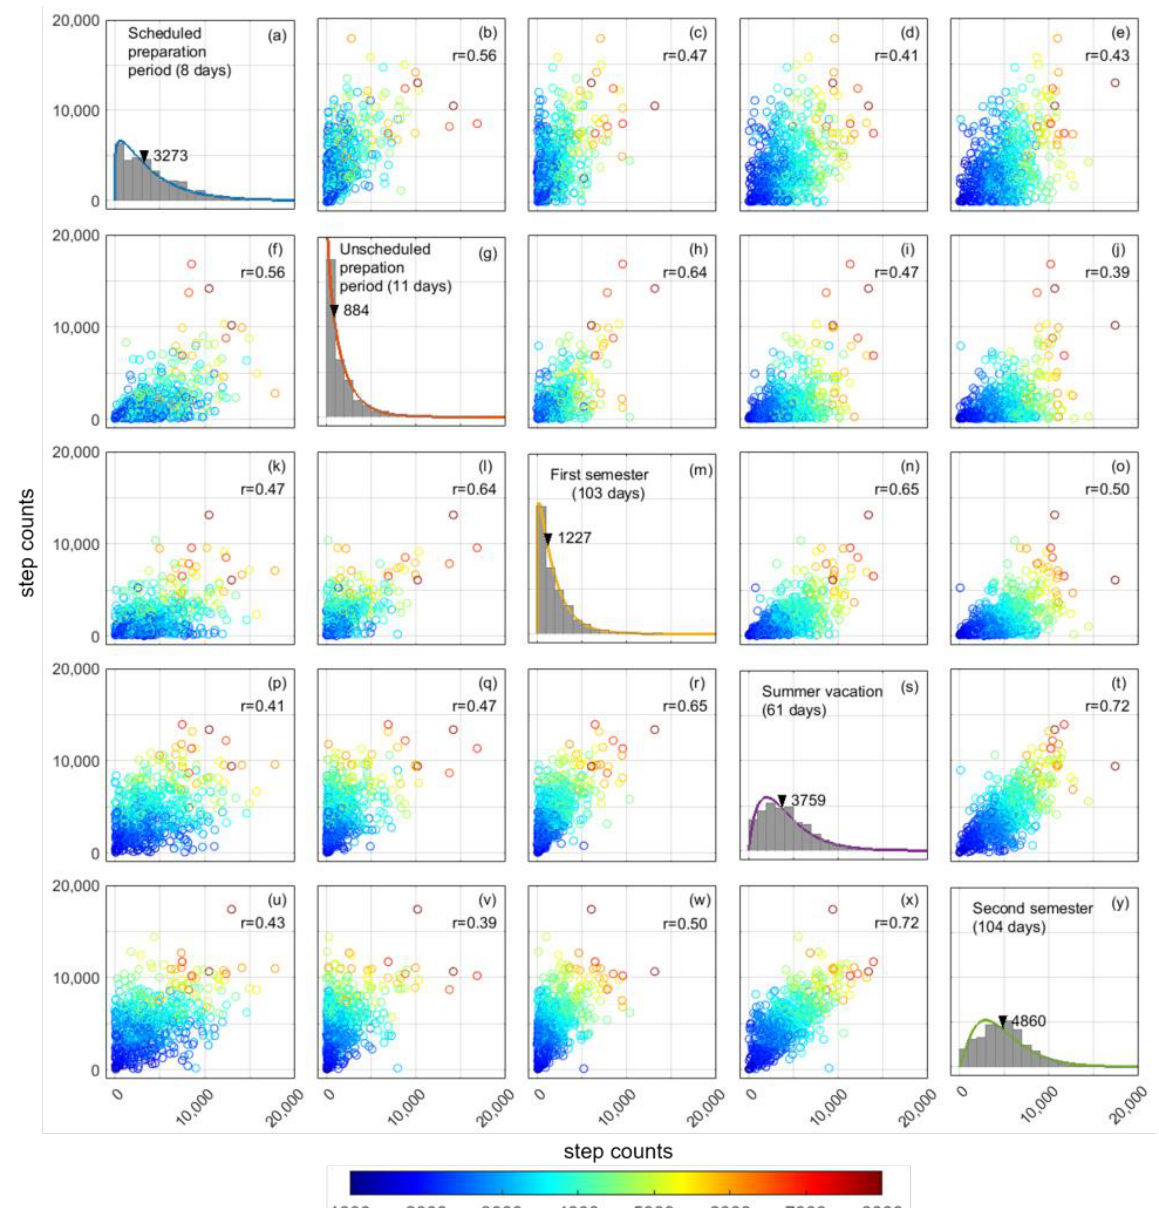
Figure 4. Cross correlation matrix of median daily step counts during five periods according to the academic calendar. Color of scatter represents the median step count of 603 participants during the entire recording period. Diagonal panels show the distribution of daily step counts during five periods (a, g, m, s, y). The arrow and value in histogram show the median value across participants during the period. Other panels show the relationship between two parameters. Figure 5d–f show the time-series changes in daily step counts with a 7-day moving average (gray) and the median value across participants in each of the three clusters (red, green, and blue). Clusters 1 (31% of participants) and 3 (47% of participants) show relatively high and low daily step counts, respectively. Cluster 2 (22% of participants) shows a relatively low daily step count from April to May. The daily step count then increases starting from June, as shown in clusters 1 and 2. Figure 5g shows the biplot of the scores of 603 participants divided into three clusters with loading vectors of five variables on the plane determined by two principal